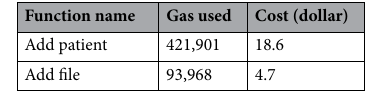
Table 2. Transaction cost of adding patients and